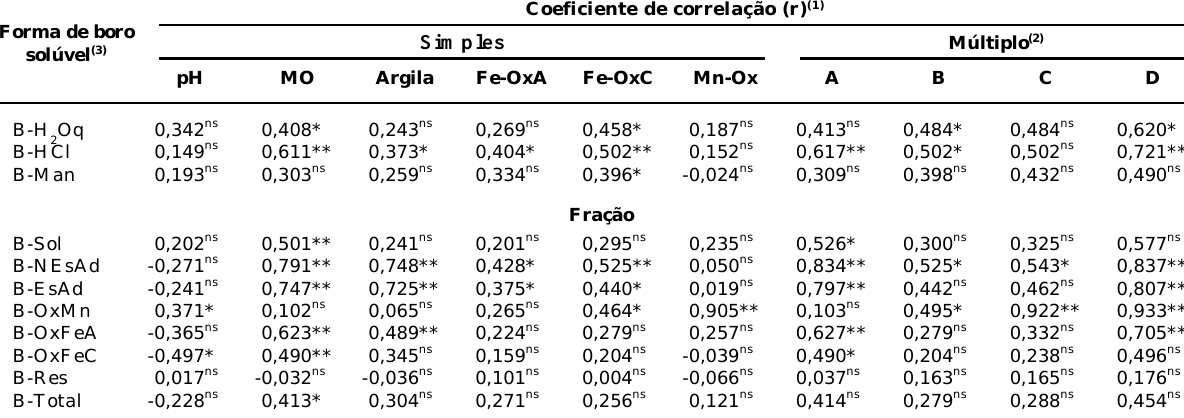
Quadro 4. Coeficientes de correlação simples e múltiplos entre as formas de boro no solo